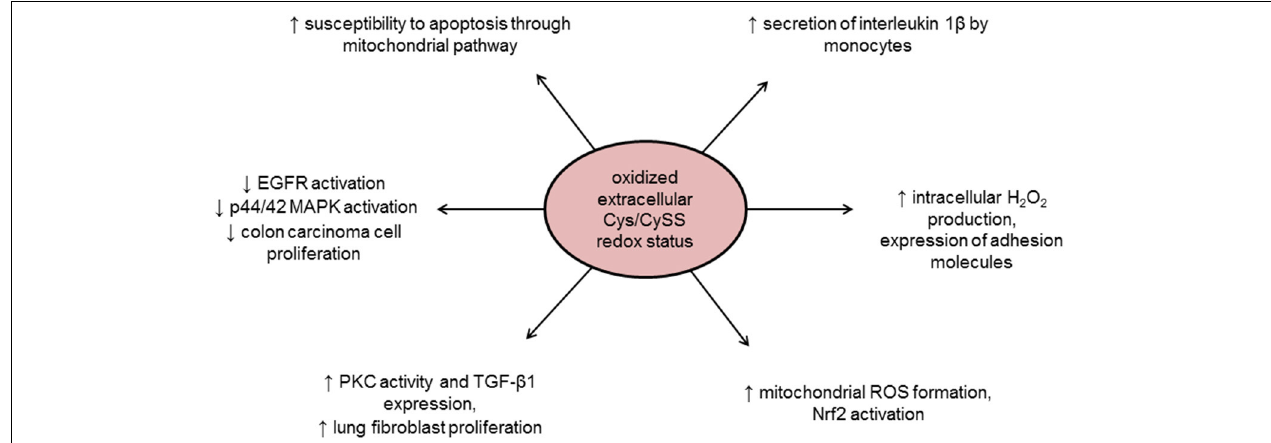
FIGURE 2 | Intracellular effects of oxidized extracellular redox conditions. Cys/CySS, cysteine/cystine ratio; EGFR, epidermal growth factor receptor; MAPK, Mitogen-activated protein kinase; Nrf2, NF-E2-related factor 2; PKC, protein kinase C; ROS, reactive oxygen species; TGF- β 1, transforming growth factor beta 1.